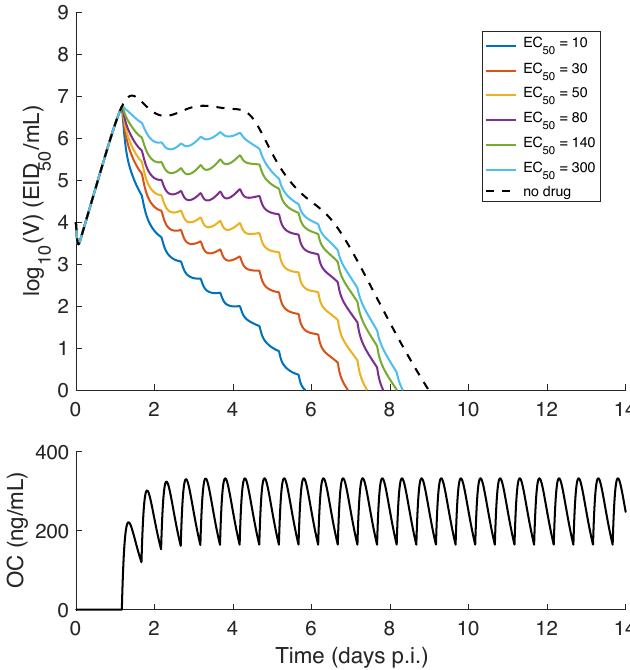
Figure 6. Dependence of viral load profile on drug efficacy for the IR model. The time course of plasma oseltamivir carboxylate (OC) concentration is shown in ( B ). For EC 50 varying from 10 ng/mL to 300 ng/mL, corresponding viral load solutions are shown in ( A ) with different colours. The solution with no drug applied is shown by the dashed black